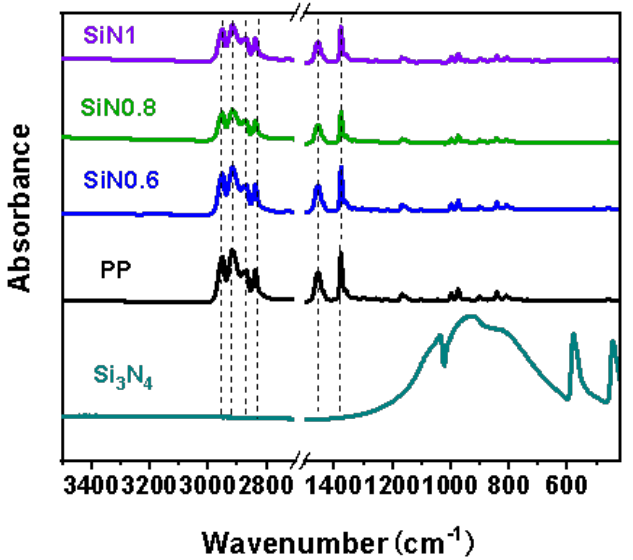
Figure 6. IR spectra of Si 3 N 4 and PP with different Si 3 N 4 contents.